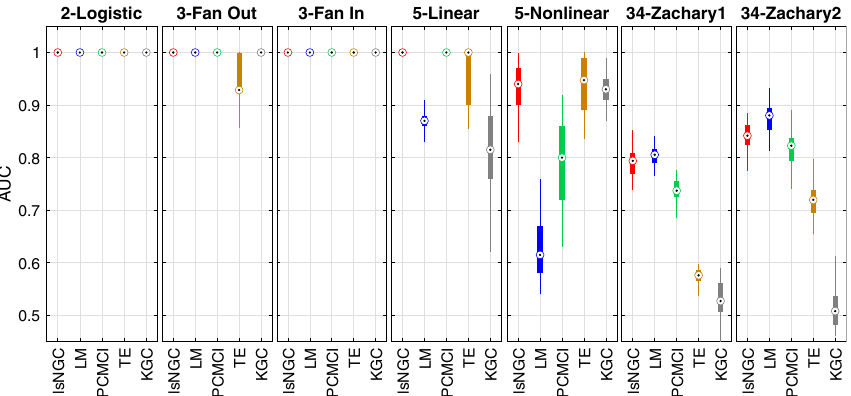
Figure 4. AUC results for the various networks comparing different methods, visualized as boxplots. Figure generated with MATLAB R2016a 40 . The bottom end of the box represents the first quartile and the top of the box represents the third quartile. The circle with a dot in the box represents the distribution median. A general trend that is noticeable here is that the performance drops for all approaches as the number of nodes increases. Note that lsNGC performs competitively for all